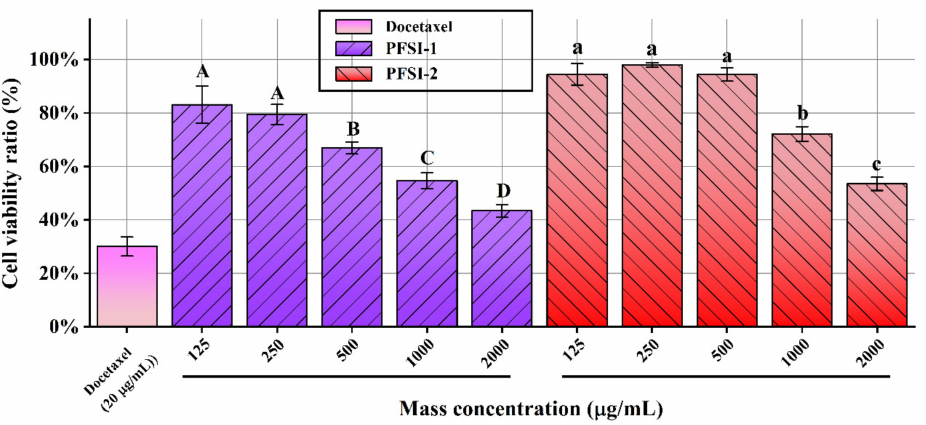
Figure 9. Effects of PFSI-1 and PFSI-2 on the viability of HL-7702 cells. (Note: the same small (capital) letters indicate no significant difference between groups, and different small (capital) letters indicate a significant difference between groups, p <